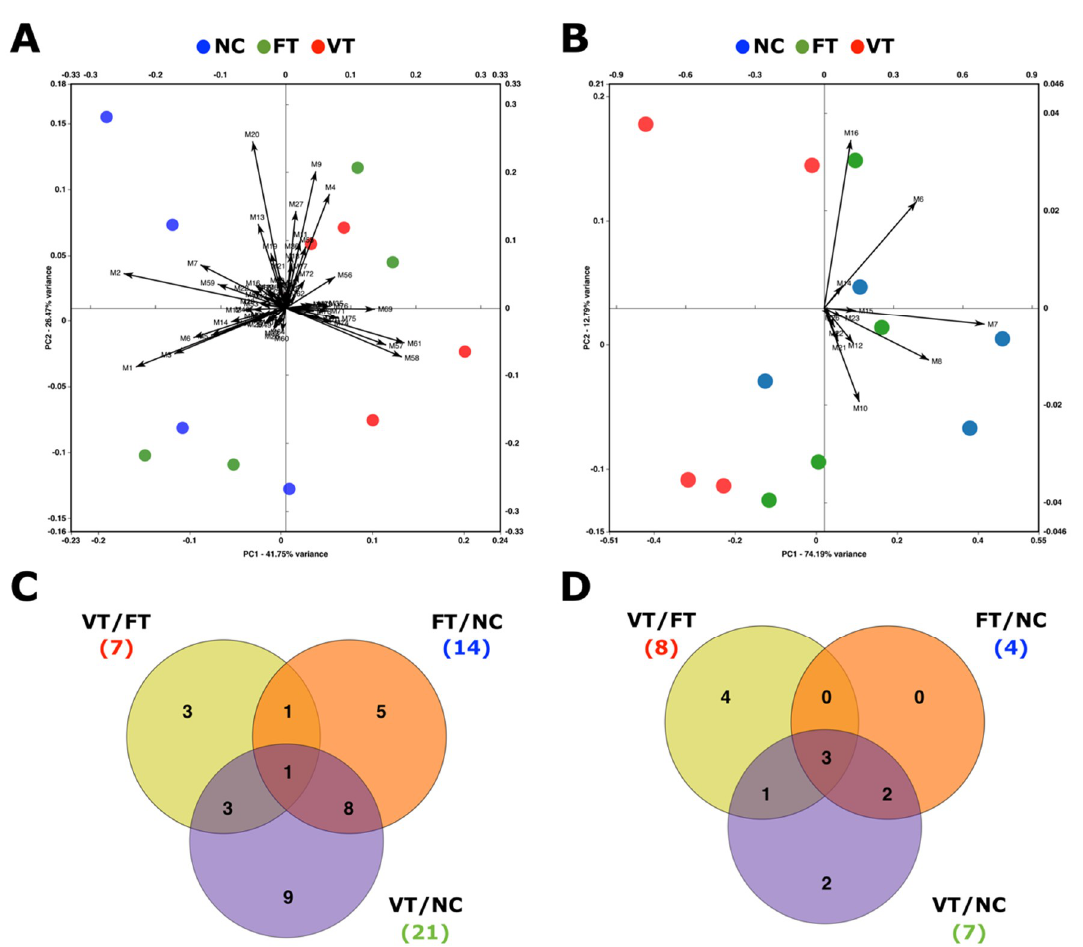
Figure 1. Unbiased metabolomic data (untargeted study) comparing the metabolic profile of naturally-conceived (NC) embryos and those in vivo developed after fresh embryo transfer (FT) and vitrified embryo transfer (VT). Principal components analysis biplots of the ( A ) semi-polar and ( B ) non-polar metabolites. Venn diagrams comparing the number of targeted ( C ) semi-polar and ( D ) non-polar di ff erentially accumulated metabolites after fresh embryo transfer (FT / NC), vitrified embryo transfer (VT / NC), and embryo cryopreservation (VT /